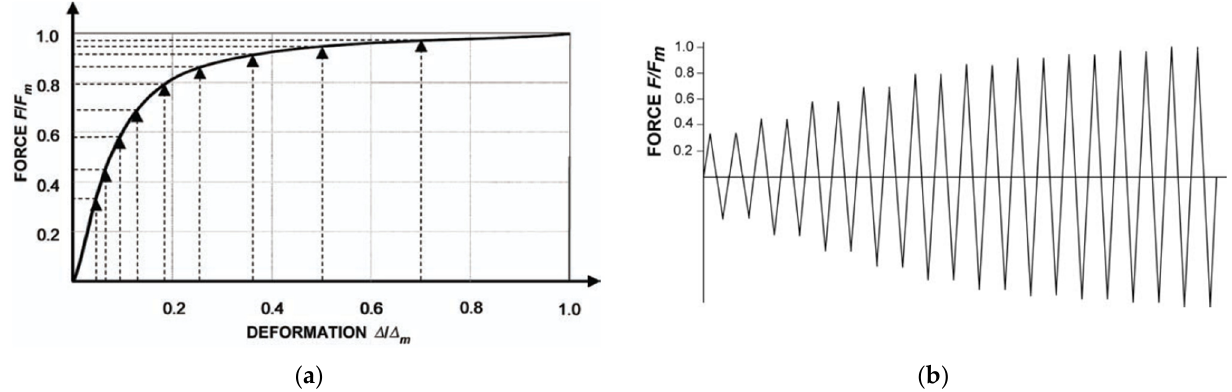
Figure 6. FEMA 461 force-controlled quasi-static protocol: ( a ) force-displacement NE response and ( b ) derived loading history.